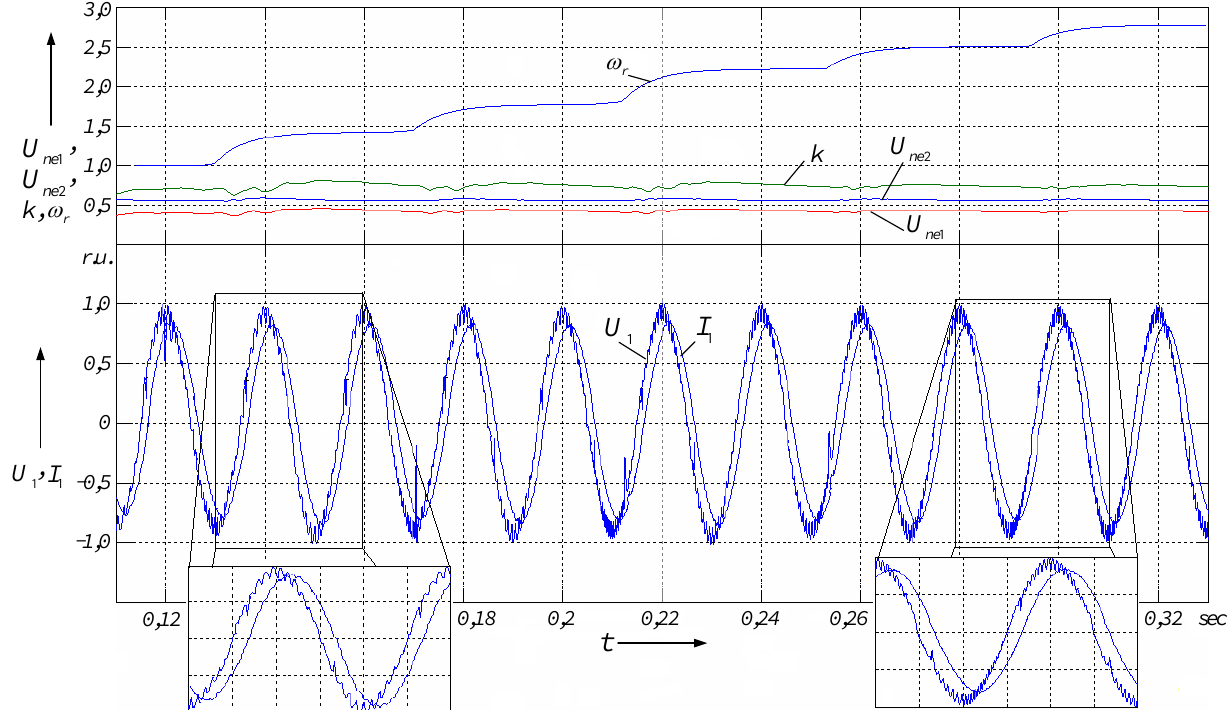
Figure 11. Load voltage and current waveforms of MCS when changing load power while stabilizing output electrical parameters of MCS by means of AC excitation winding circuit